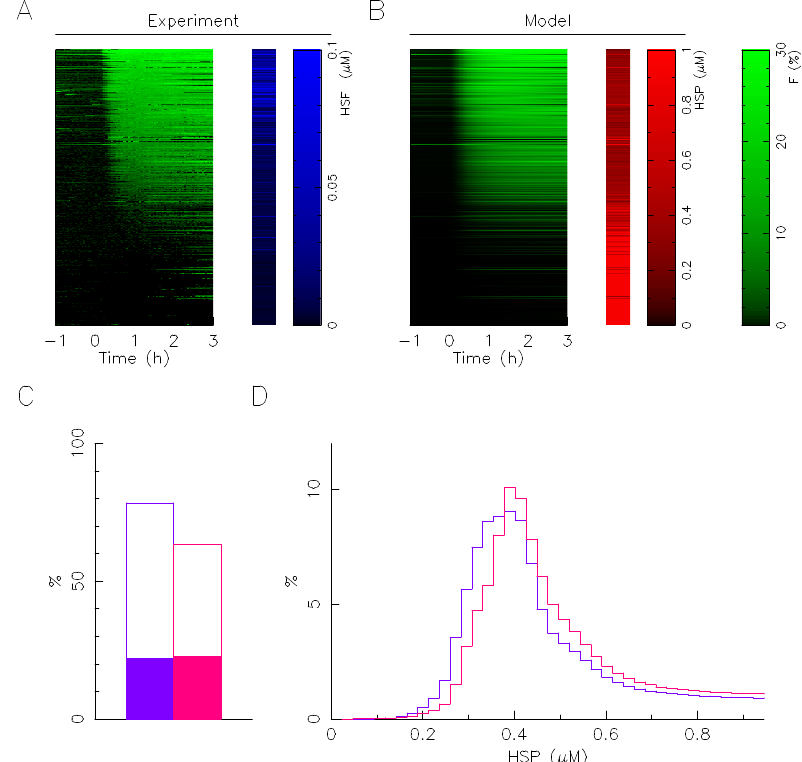
Figure 6. Mathematical modeling predicts HSP expression heterogeneity. ( A ) Fluorescence dynam- ics of single cell foci (green) and total fluorescence measurement of HSF1:eGFP (blue). Each line corresponds to a single cell ( B ) cell-by-cell best fitting of the fluorescence foci (green) and predicted value of molecular chaperone expression (red). The data correspond to a temperature of 43 ◦ C applied on a population of cells grown on collagen coating. ( C ) Percentage of successful single cell fitting at 43 ◦ C (col+/col − ; red/blue). Solid rectangles represent control: no fitting of molecular chaperone expression level, but taking into account HSF1 heterogeneity measured by HSF1:eGFP fluorescence. ( D ) Molecular chaperone expression distribution prediction from the fitting results at 43 ◦ C (col+/col − ;